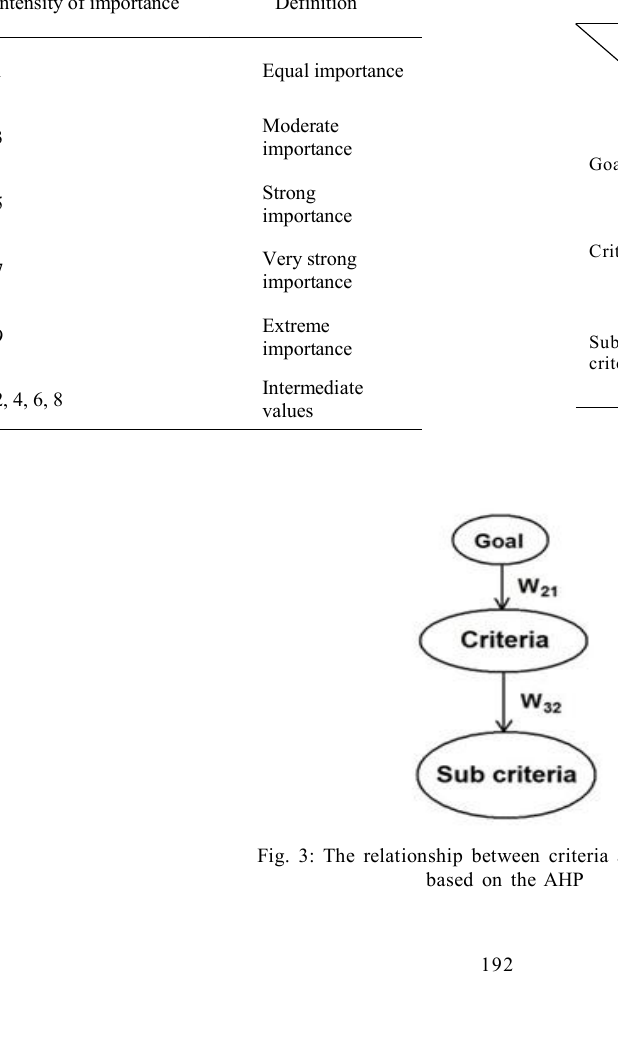
Table 3: Structure of the primary unweighted matrix in the hierarchical model to estimate the spatial potential of flooding based on the AHP